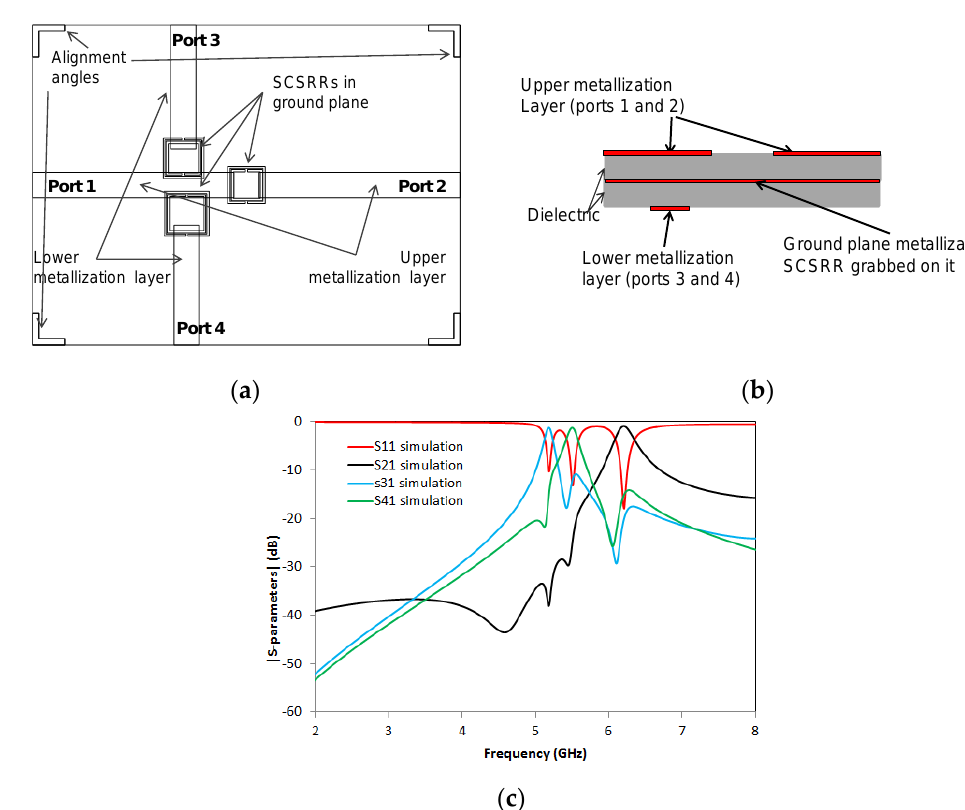
Figure 27. ( a ) Top view overlapped layer distribution of 2-layer triplexer, which is SCSRR based. Mixed output ports in upper and lower layer are designed. ( b ) Front view layer distribution. ( c ) Simulated S11 (dashed red line), simulated S21 (dashed black line), simulated S31 (dashed blue line), and simulated S41 (dashed green line).